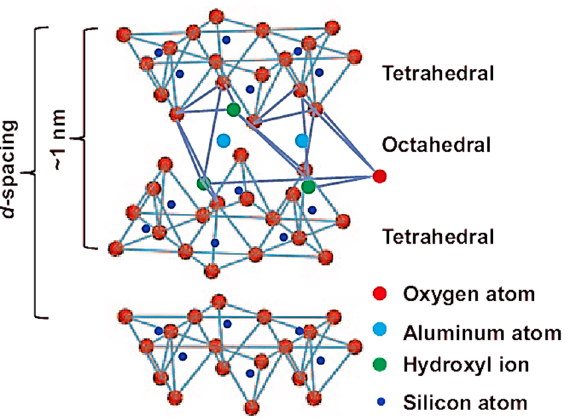
Figure 1. Structure of nanoclay (montmorillonite) [44]. Reproduced with permission from Springer.